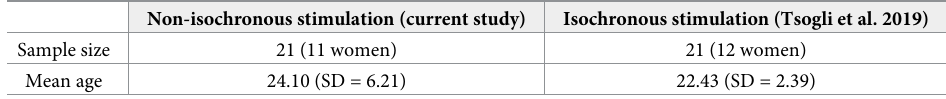
Table 1. Comparative view of demographic information between the two